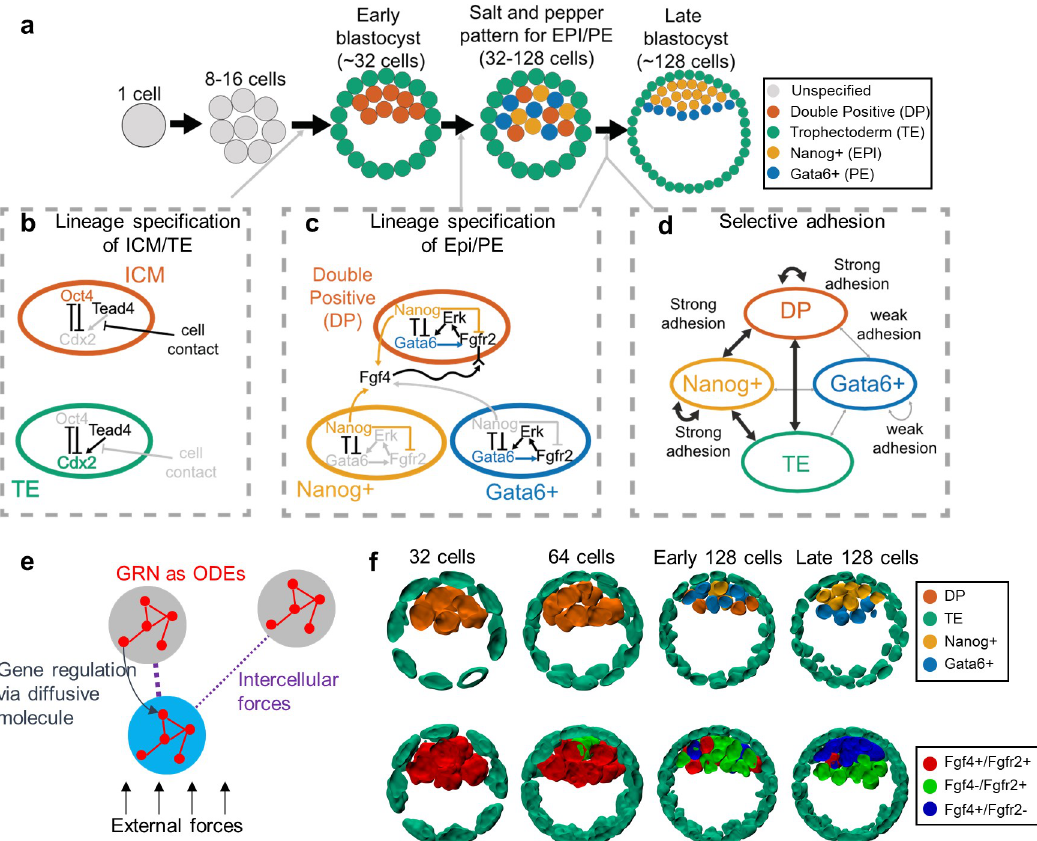
Fig 1. A multiscale model for early embryo development from fertilization to late blastocyst stage. (a) Embryo shapes in different stages. The circle color indicates the cell type: Grey for unspecified cell; Green for Trophectoderm (TE) cell; Red for inner Cell Mass: double positive of Nanog and Gata6 (DP); Yellow for Nanog high and Gata6 low (Nanog+); Blue for Gata6 high and Nanog low (Gata6+). (b) Gene regulation models for ICM specification before early blastocyst stage. The grey color represents weak cell contact or weak gene expression. (c) Gene regulation models for Nanog+/Gata6+ specification during early to late blastocyst stage. (d) Modeled selective adhesion between different cell types through early to late blastocyst stage. (e) A schematic illustration of the multiscale model incorporating spatial and gene expression dynamics of the cells. The correspondence to equations are as follows: GRNs, Eqs (1)–(5); intercellular forces, Eq (7); intercellular gene regulation, Eqs (5) and (6); external forces, S1 Text Eqs (3) and (4). (f) Simulated embryo with Nanog/Gata6 and Fgf4/Fgfr2 expression at different